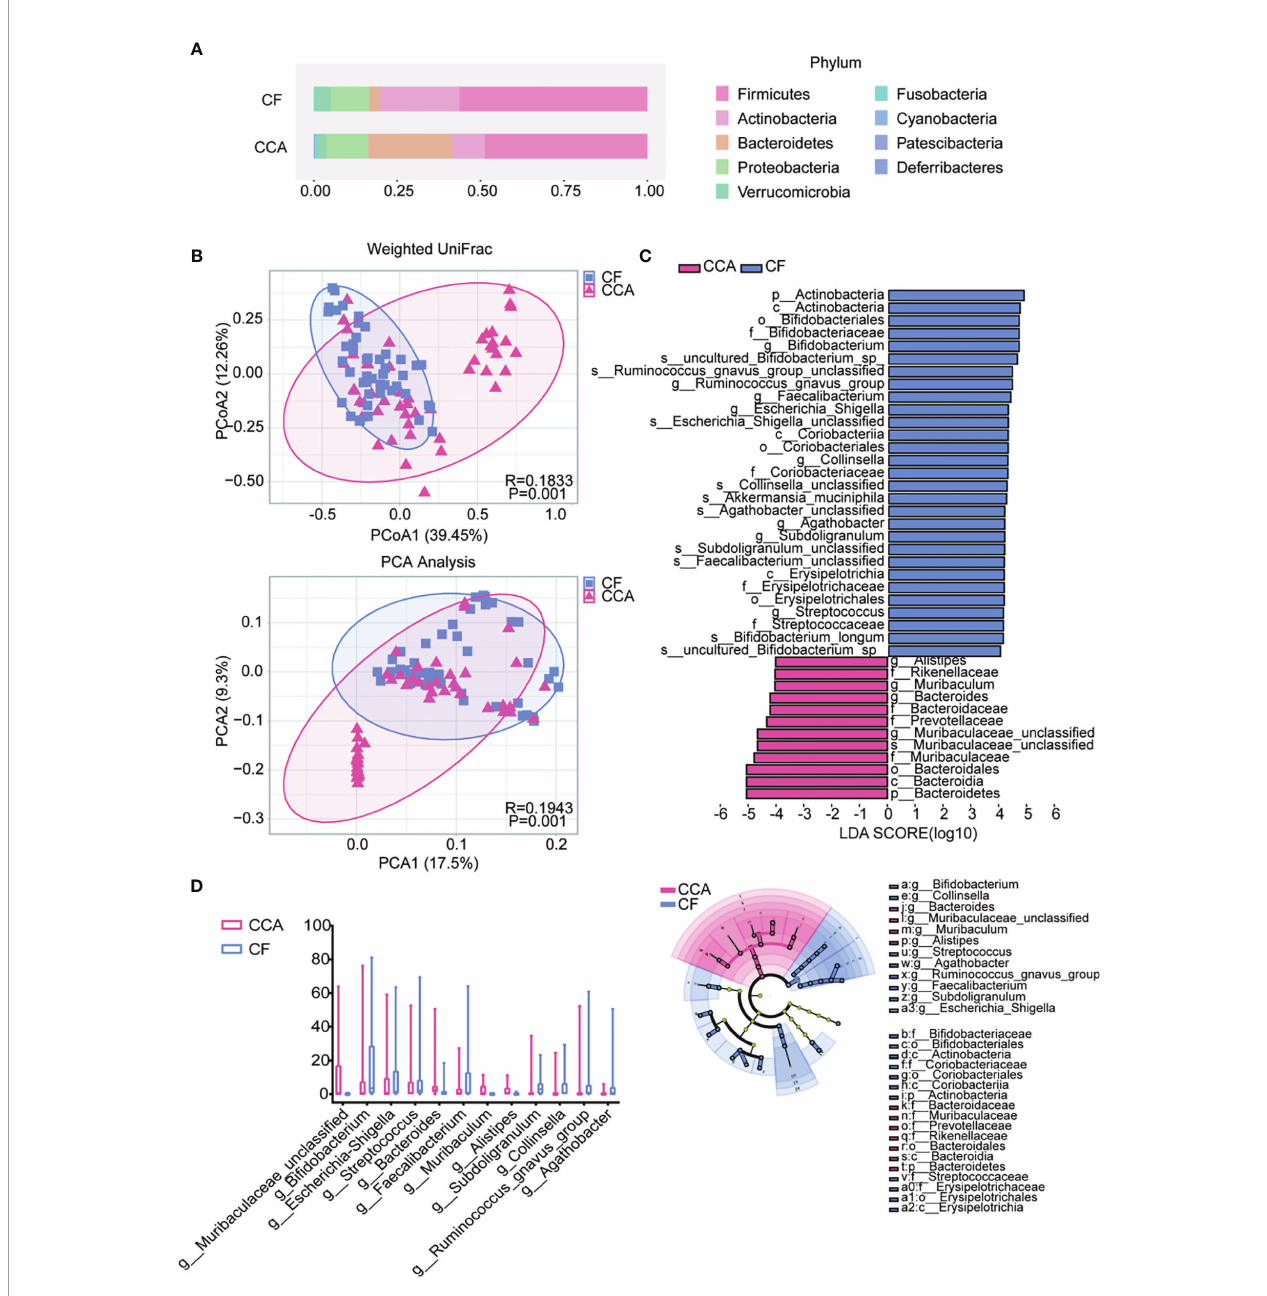
FIGURE 4 | The differences in gut microbiota among the cholangiocarcinoma (CCA) and cholelithiasis [cancer-free (CF)] patients. (A) Composition of the gut microbiota at the phylum level. (B) Principal coordinates analysis (PCoA) index and principal component analysis (PCA) based on weighted UniFrac distance metric for CF and CCA (P = 0.001, P = 0.001). (C) Differentially abundant taxa between CF and CCA samples analyzed by linear discriminant analysis (LDA) effect size (LEfSe) were shown in histogram and cladogram. All listed taxa were signi fi cantly (Kruskal – Wallis test, P < 0.05, LDA score >4) enriched in their respective groups. (D) Box plot showing the relative abundances of the top 15 differentially expressed taxa identi fi ed by LEfSe (P <